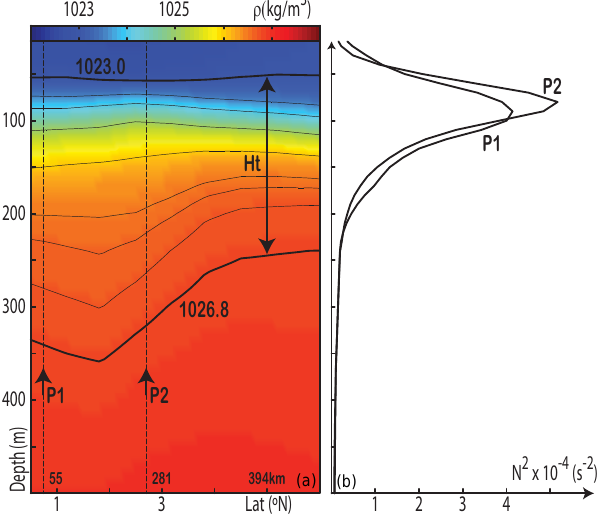
Figure 11. (a) May climatic vertical density section running along the green dashed line defined in Fig. 9 for generation site A. Selected isopycnals are also shown to highlight a density front.